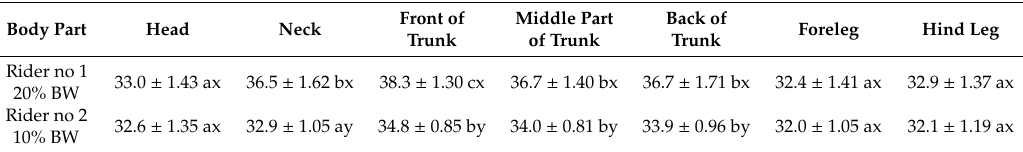
Table 5. Post-exercise average superficial temperatures ( ◦ C) of the studied body parts of the horse (Means ± SD).